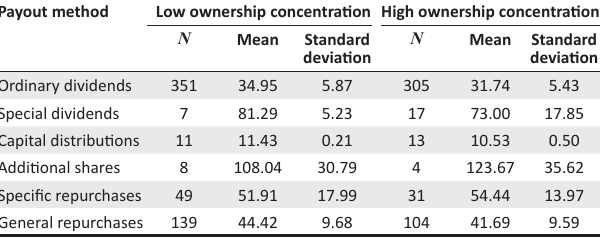
TABLE 1: Descriptive statistics of different payout methods.